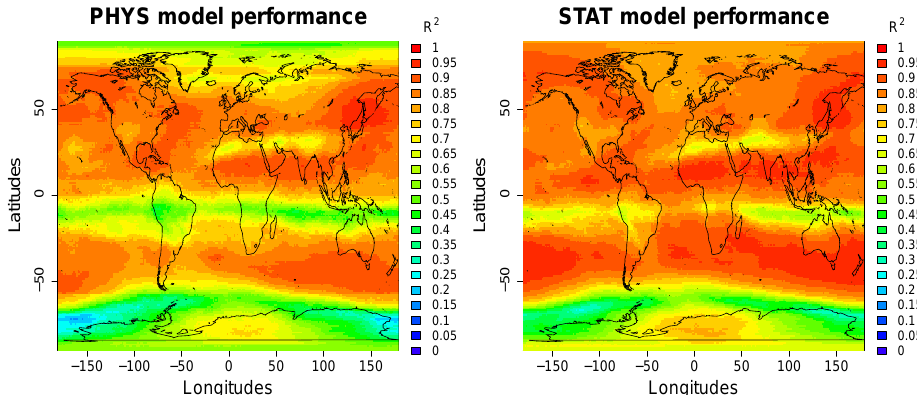
Figure 10. The performance of the PHYS regressions (left plot) and STAT regressions (right plot) in terms of R 2